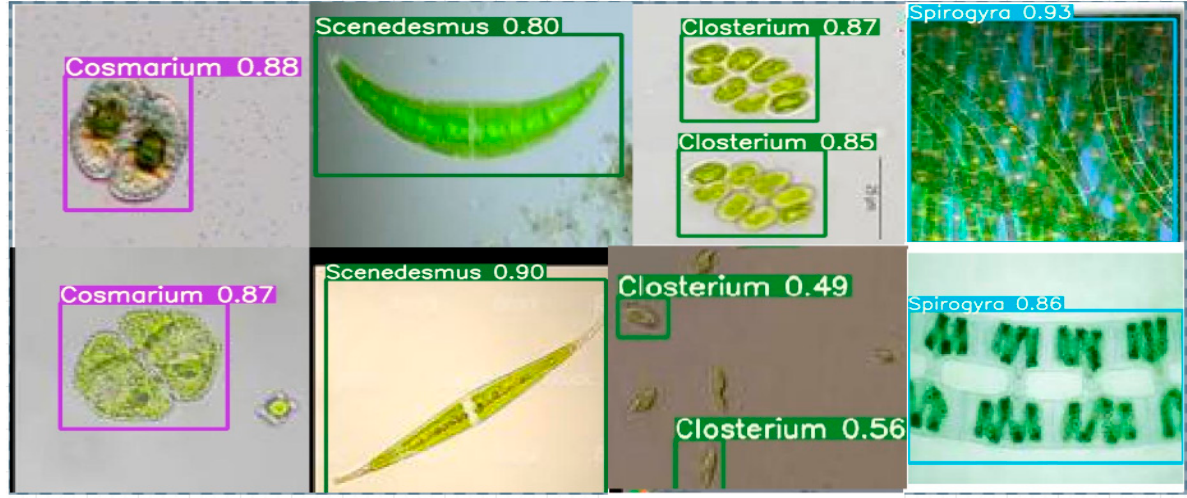
Figure 7. The detection and classification performance of YOLOv5.